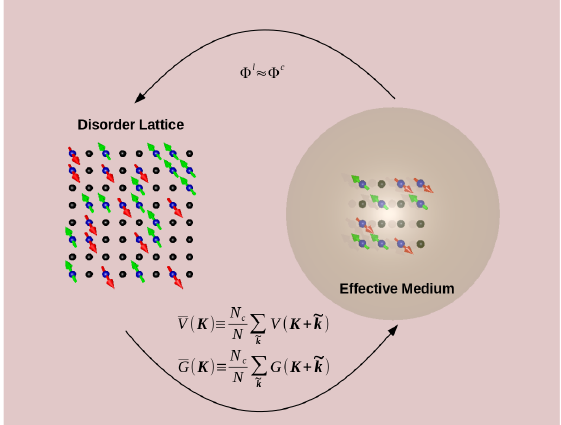
Figure 11. The mapping from the cluster to the lattice is accomplished by replacing the Green’s function and interaction by their coarse-grained analogs in the diagrams for the generating functional, self-energy and irreducible vertices. In the map back to the cluster, this self-energy is used to calculate a new cluster host Green’s